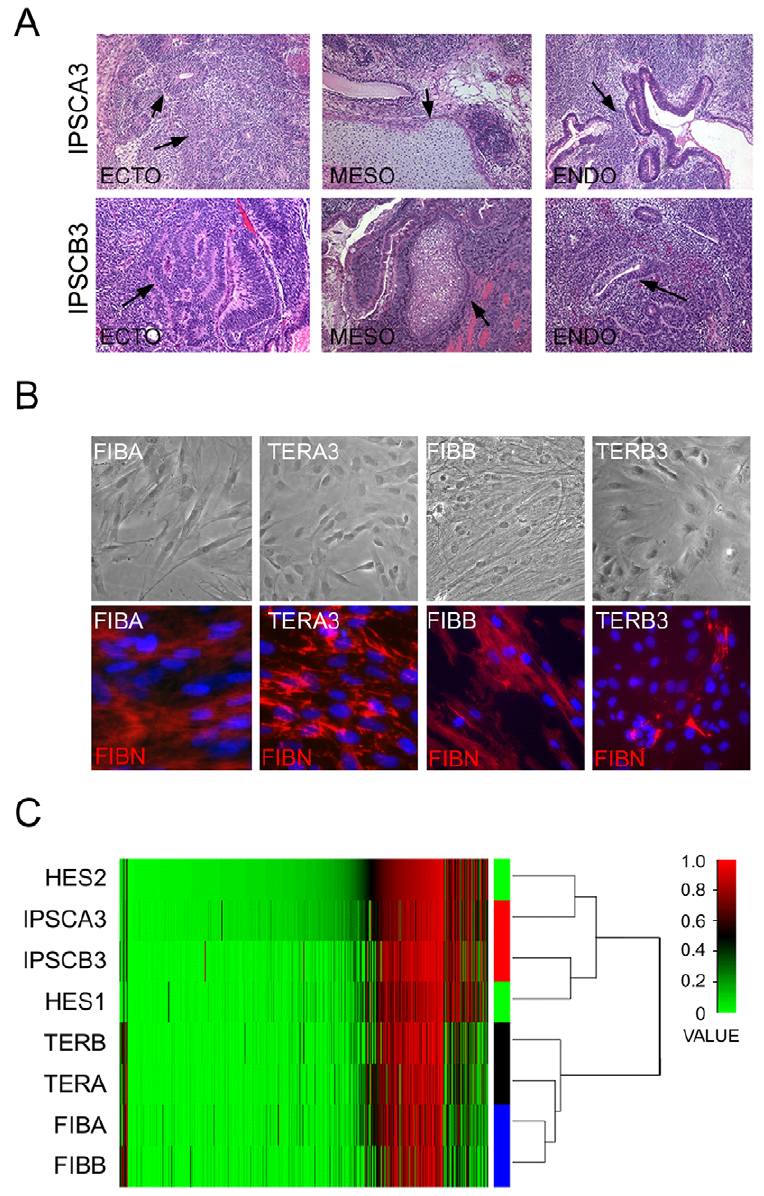
Figure 4. Indicators of pluripotency and differentiation in IPSC lines. (A) Representative sections from teratomas generated from IPSC lines as labeled. Arrows in ectodermal (ECTO) tissue indicate neural rosettes, in mesodermal tissue (MESO) indicate cartilage, and in endodermal tissue (ENDO) indicate glandular columnar epithelium. mag. 100X. (B) Morphology of FIB lines and TER lines, as labeled, in phase-contrast images (top row) and stained for fibronectin (red, bottom row). mag. 400X. Blue is DNA stain. (C) Genome-wide methylation heat map and cluster analysis of representative input fibroblasts, IPSCs, TER, and hESC lines indicating that the overall pattern of methylation of IPSCs closely matches HES lines while differentiated TER lines cluster with input fibroblasts. Value indicates the level of methylation ranked from 0 (hypomethylated) to 1 (hypermethylated). doi:10.1371/journal.pone.0008124.g004 OSLN lines and as described in [15] for OSKM lines. After initial derivation, all lines were maintained as in [14].